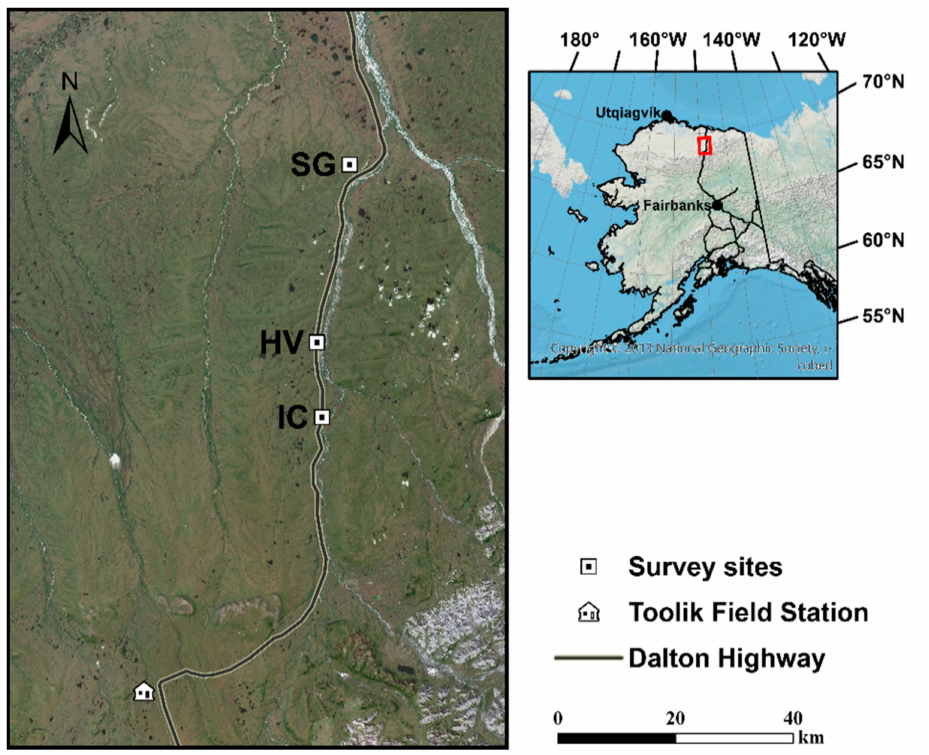
Figure 1. Locations of study sites along the Dalton Highway,